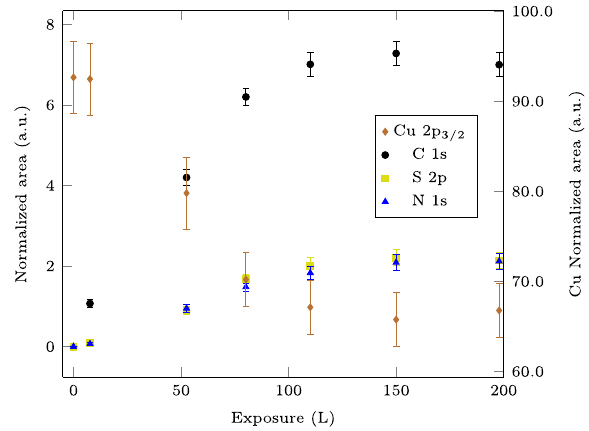
Fig. 2 Growth kinetics of 2-MBI at RT on the metallic Cu(111) surface. Evolution of the Cu 2p 3/2 , C 1s, S 2p and N 1s normalized areas with 2-MBI exposure. The error bars were estimated by adjusting the fi t of the XPS core